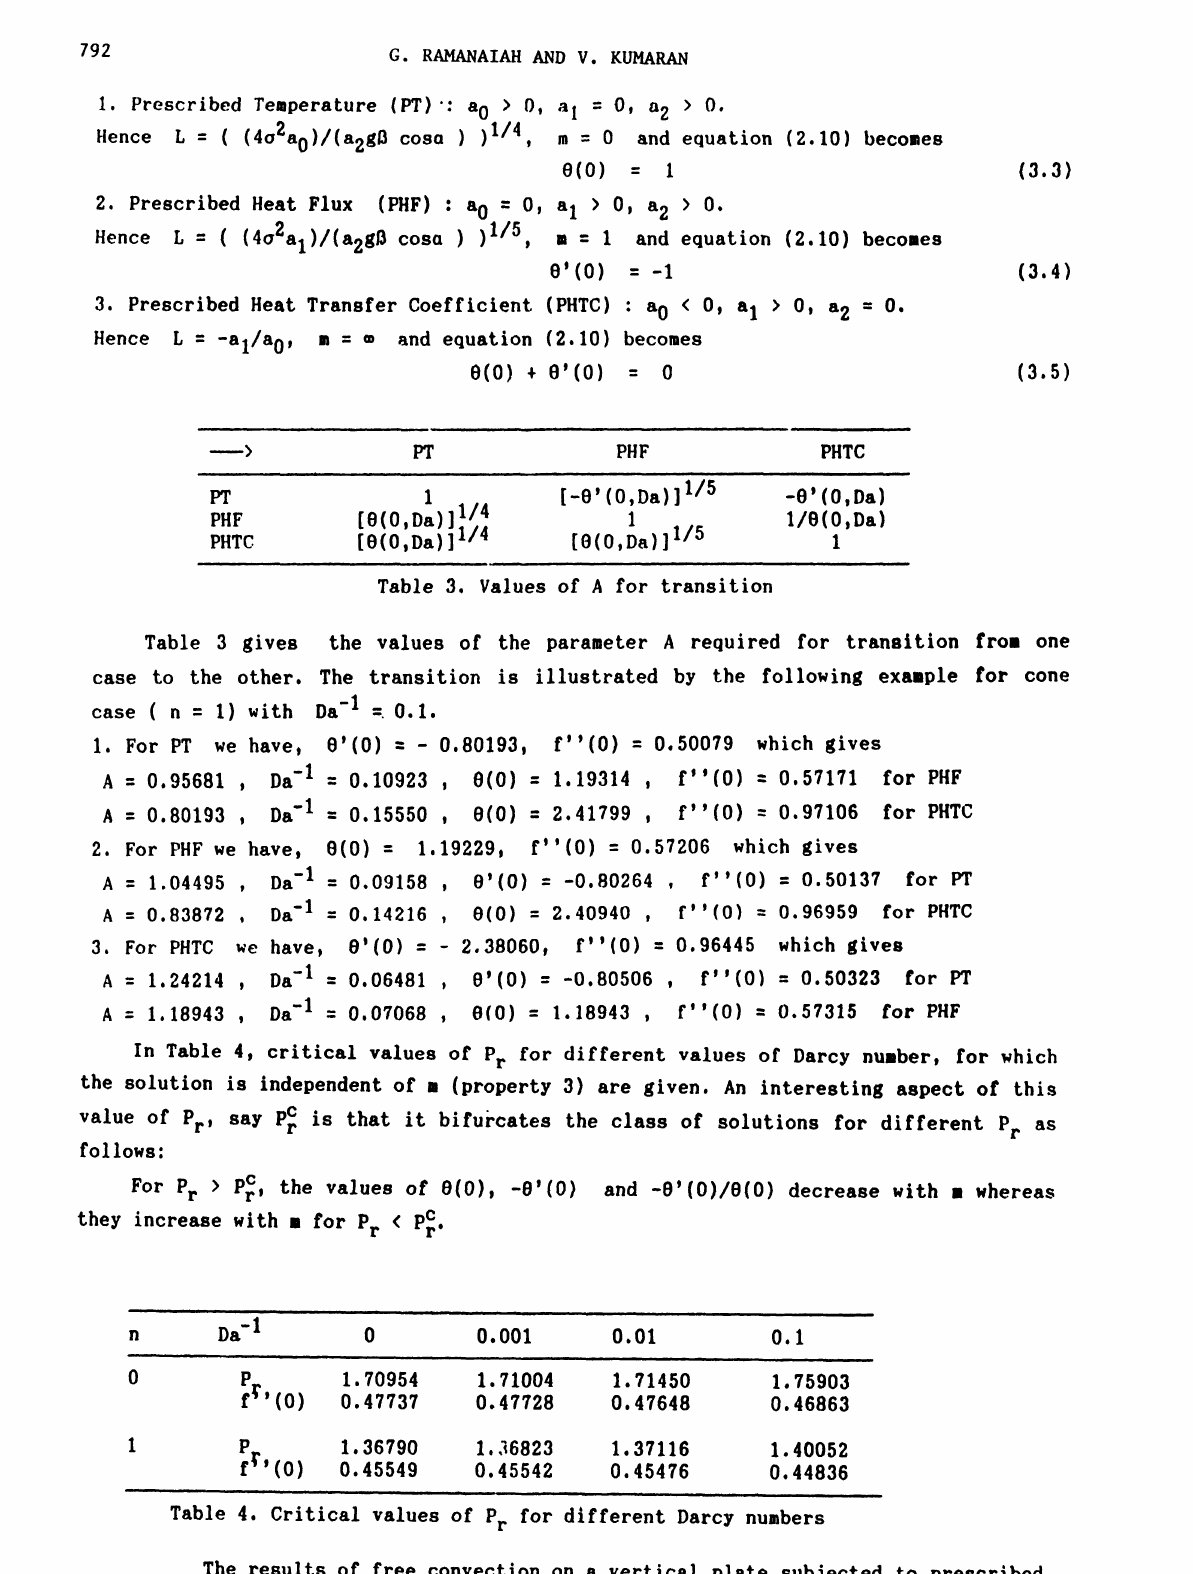
Table 3. Values of A for transition Table 3 gives